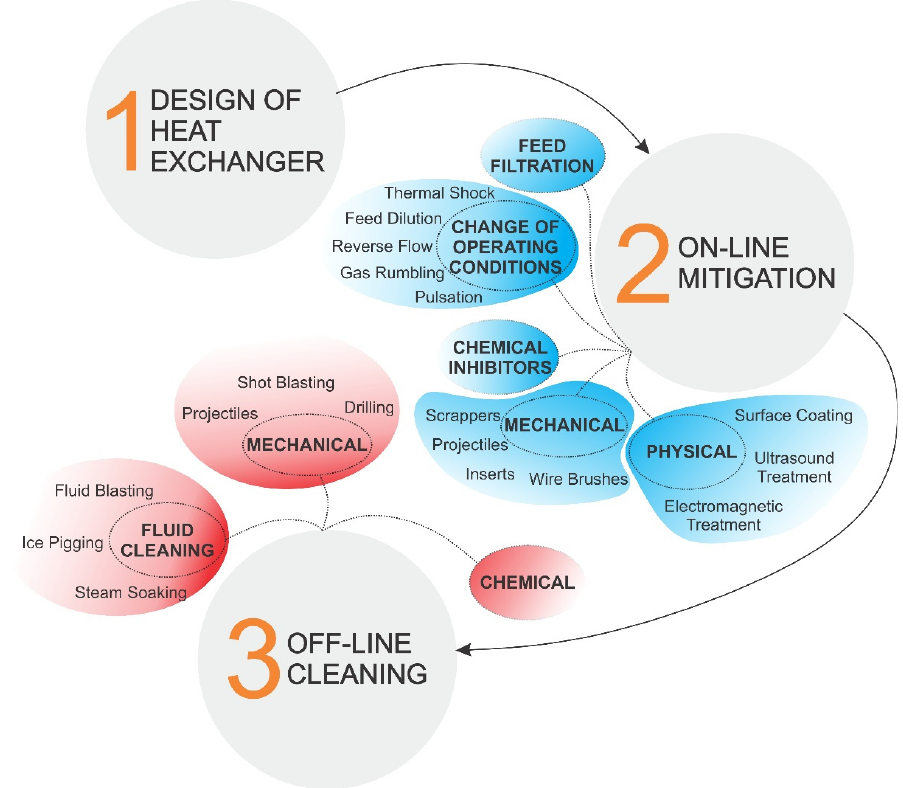
Figure 8. Various preventive and curative measures to counteract fouling of heat exchangers.